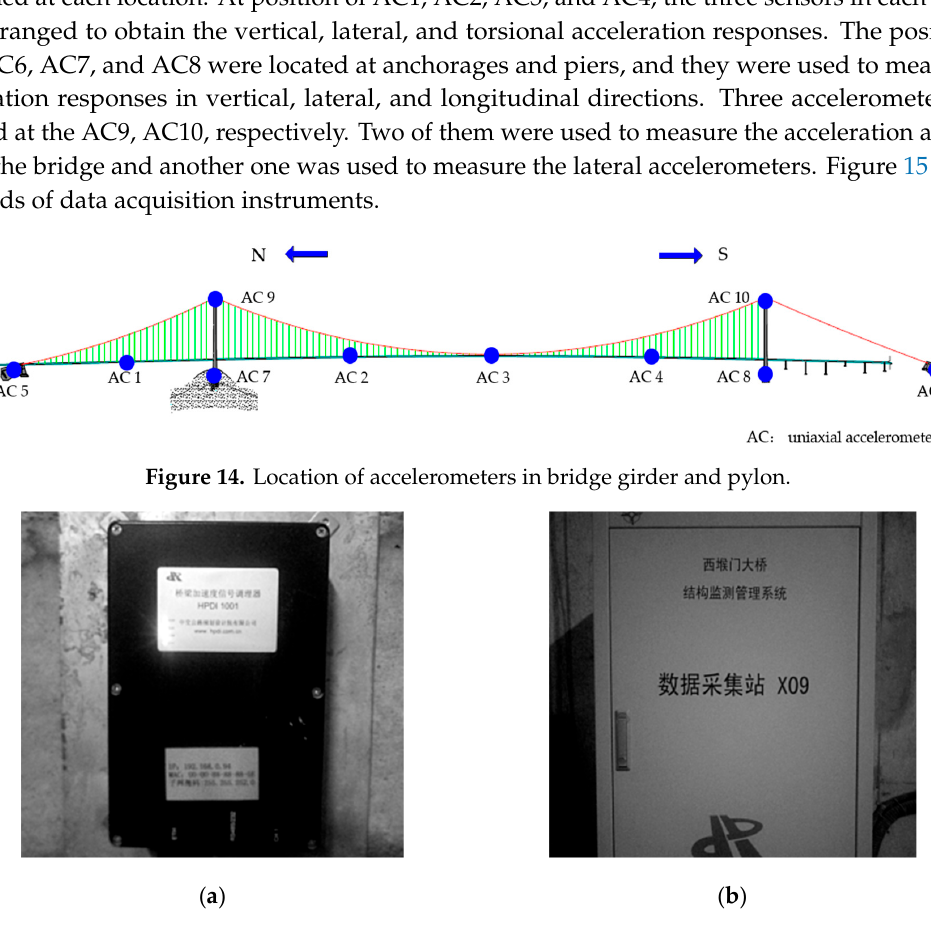
Figure 13. Location of anemometers.